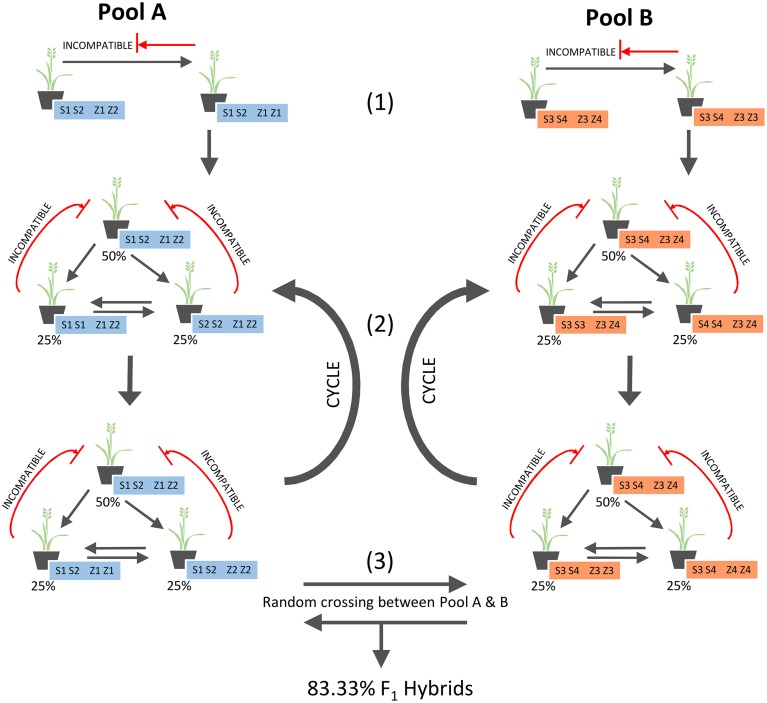
Strategy for F1 hybrid production based on Se1.